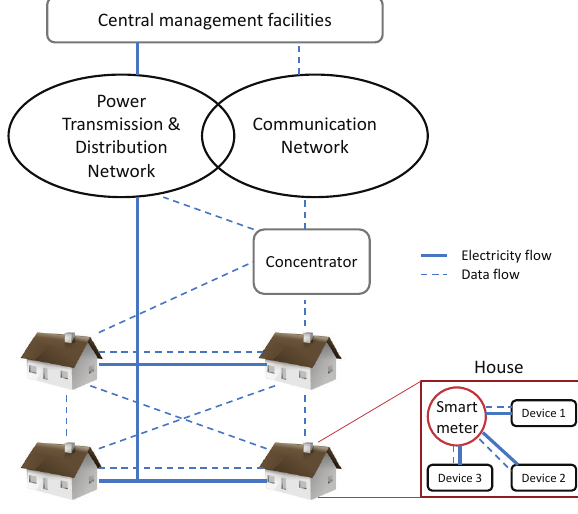
Figure 1. Smart grid